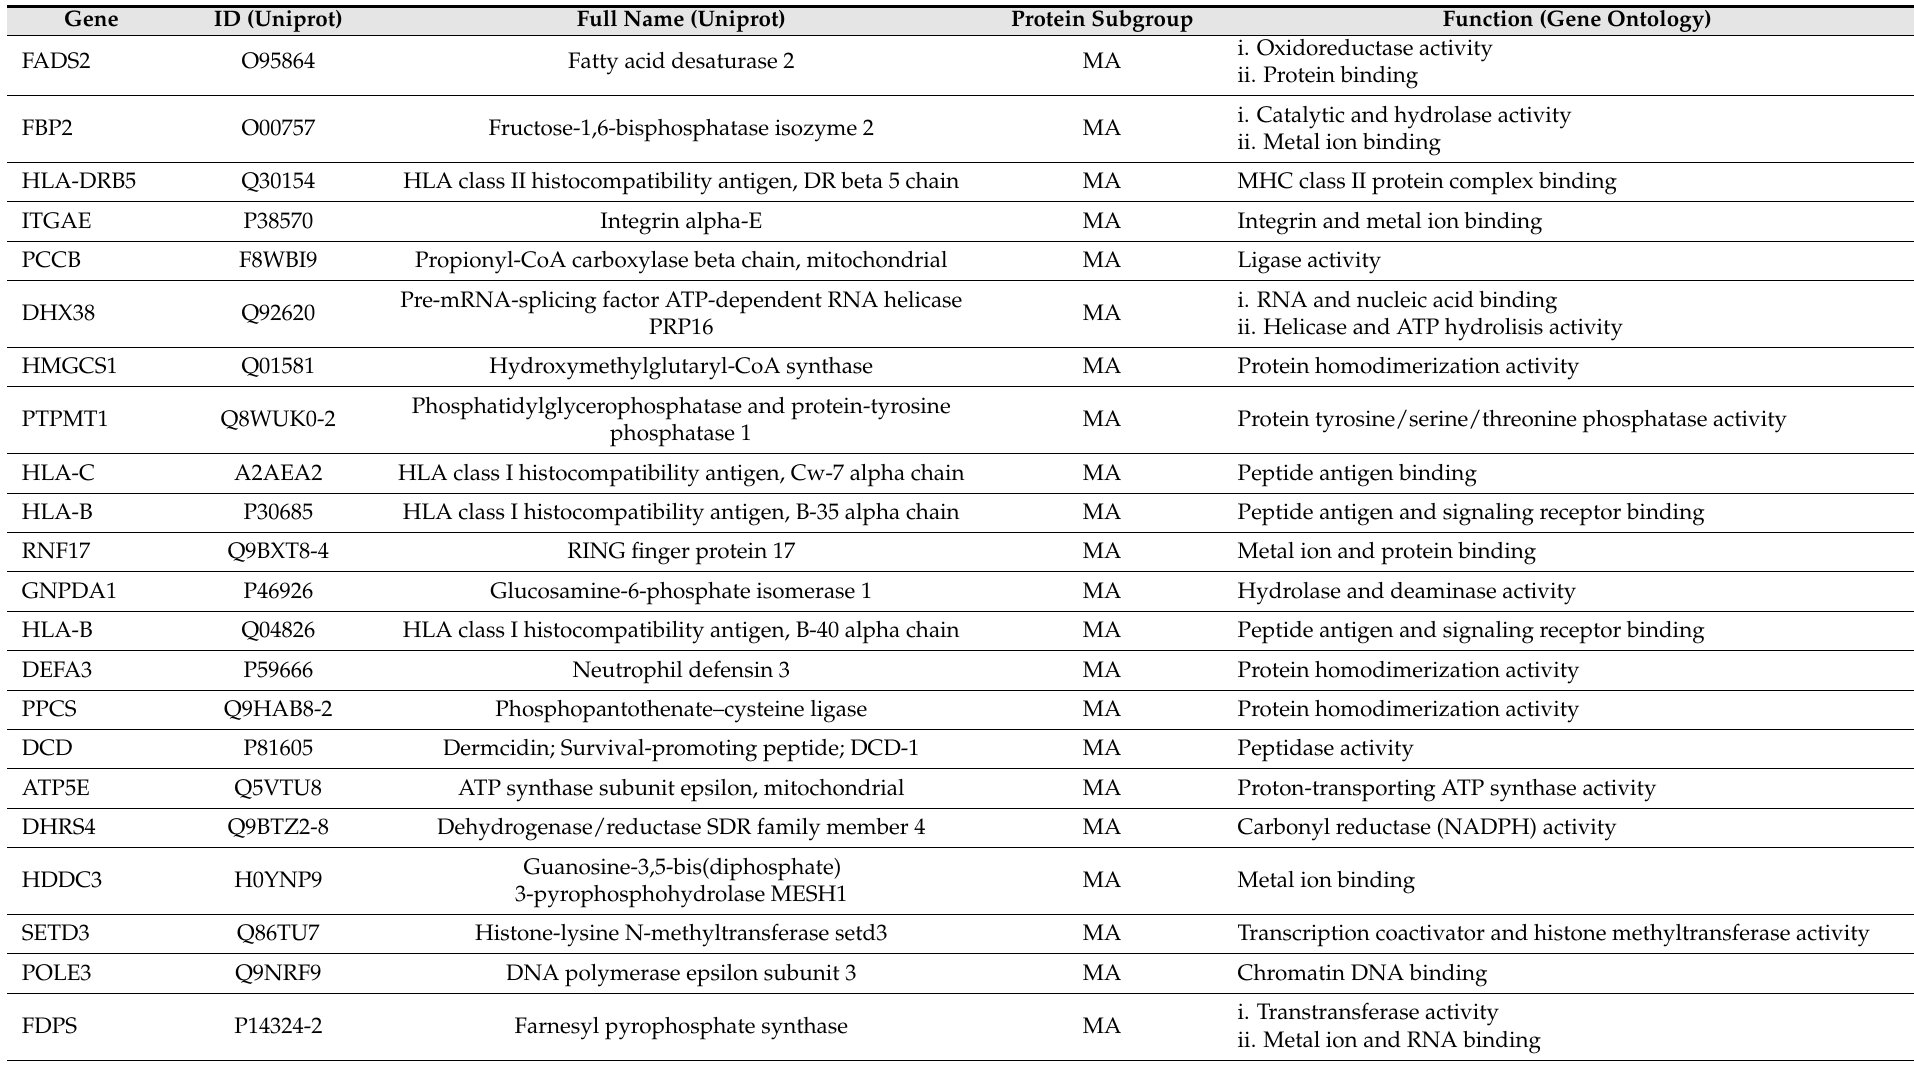
ii. Metal ion and RNA